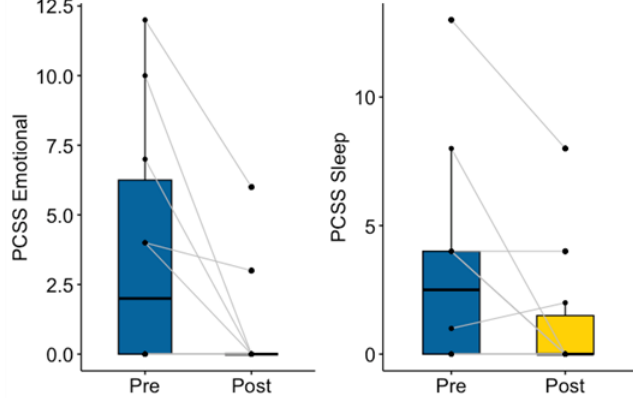
Figure 7. Mentor Pre- and Post-Mentoring Concussion Symptoms.